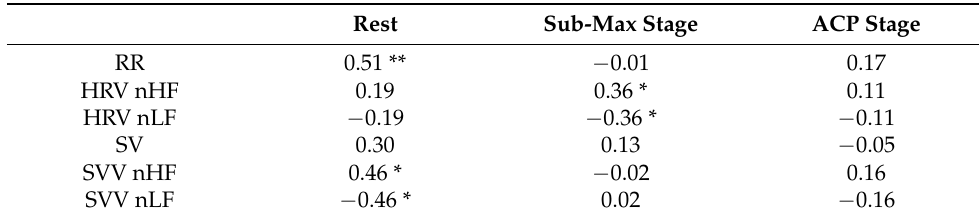
Table 3. Pearson correlation coefficients between SampEn RR and HRV and between SampEn SV and SVV.